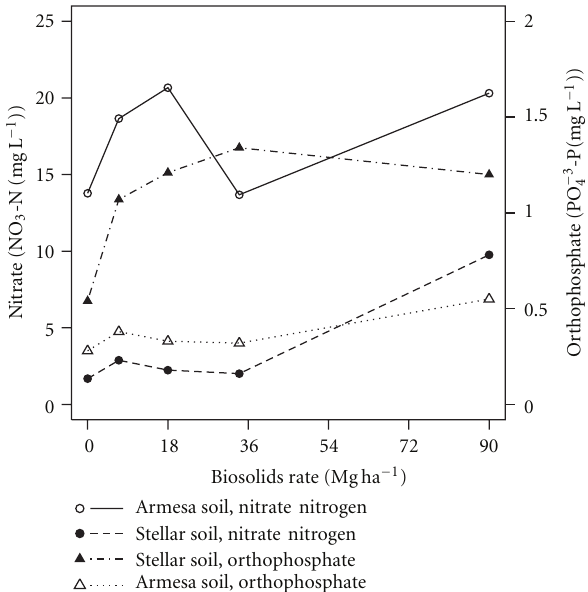
Figure 11: Nitrate nitrogen, NO 3 − -N, in runo ff water from Stellar soils as a ff ected by postapplication age (18, 12, 6, or 0.5 months) and biosolids application rate (redrawn from [15]).